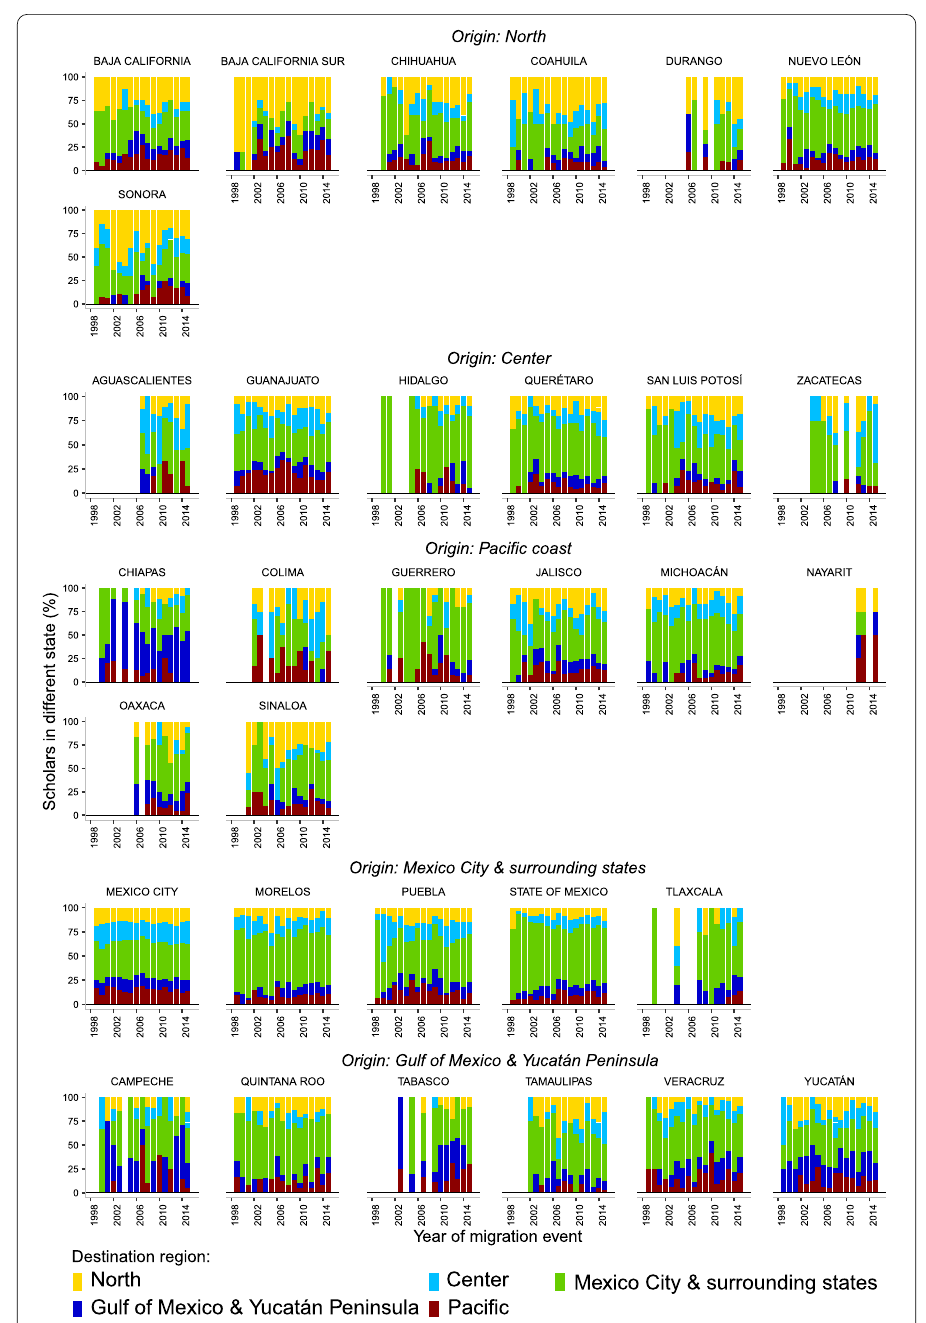
Figure 7 Destination of mobile scholars in each year by their states of academic origin. Panels show for each state of origin the intensity of movements to other regions by year. Missing bars indicate years with a low number of migration events of scholars of a given origin